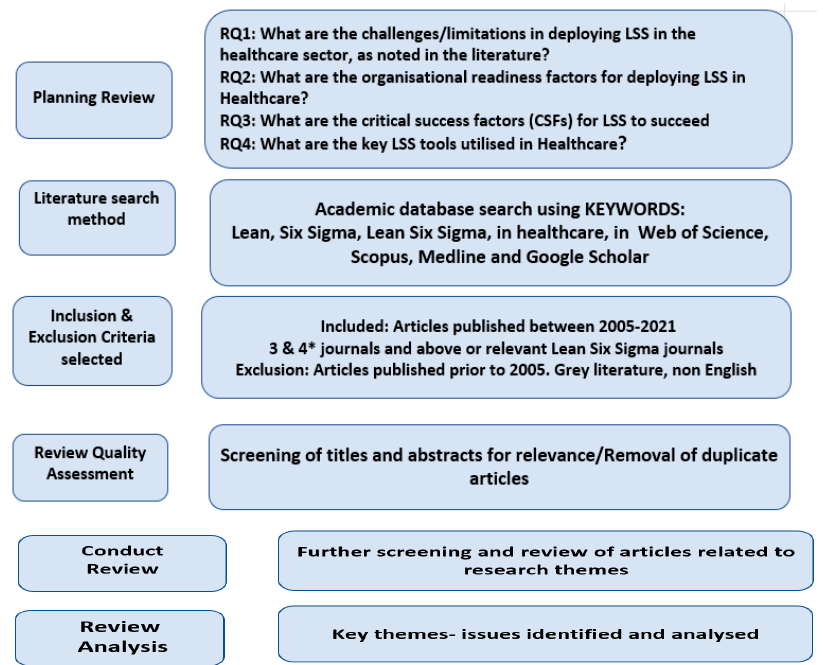
Figure 1. SLR research methodology flow chart with inclusion and exclusion criteria (* indicates star).